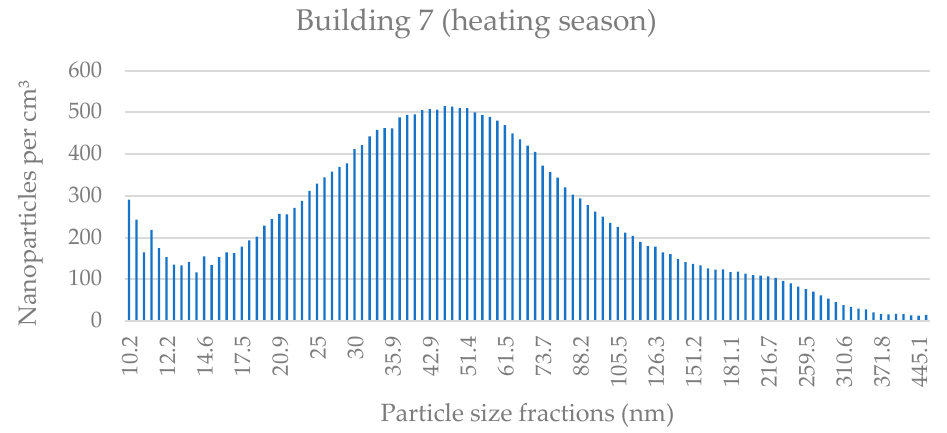
Figure A13. The average nanoparticle concentration in each size fraction in Building 7 during a one-week measurement period during the heating season.